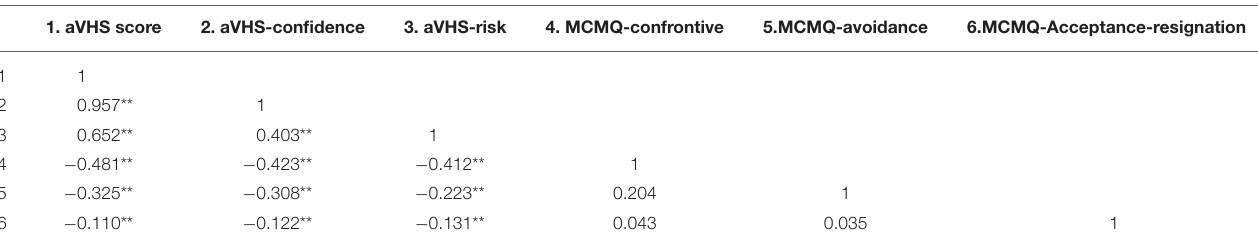
TABLE 2 | Pearon correlation analysis of vaccine hesitancy and coping